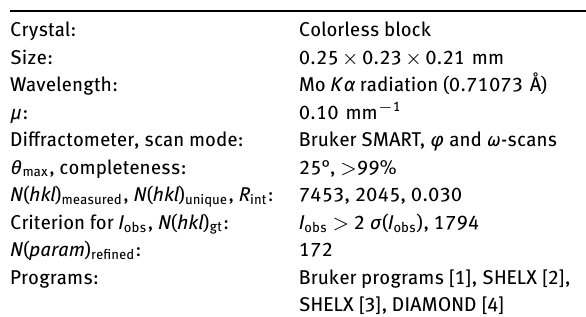
Table 1: Data collection and handling.